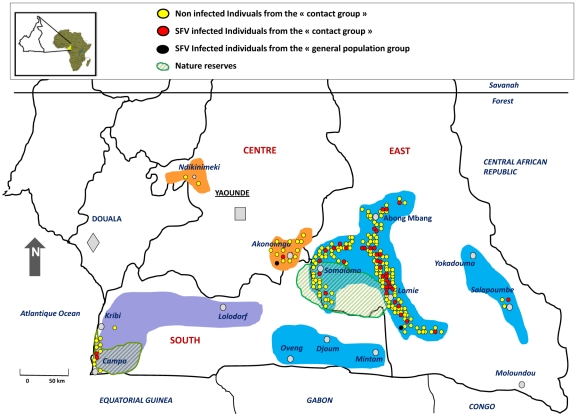
Geographic distribution of the studied population.Samples were collected systematically in the coloured areas without specific focus on a particular site. Native inhabitants of these areas include a great variety of ethnicities among which are the Banen, Yebekolo and Soo in the Centre (orange areas), the Bakola Pygmies, Mvae and Ngumba in purple colored area and finally the Baka Pygmies, the Bulu, Fang Badjoue and Zime tribes located in the blue coloured areas. The 198 individuals from the “contact group” are indicated by red (SFV-infected) and yellow (SFV non-infected) dots. The 2 SFV infected individuals from the “general population” are represented as black dots.